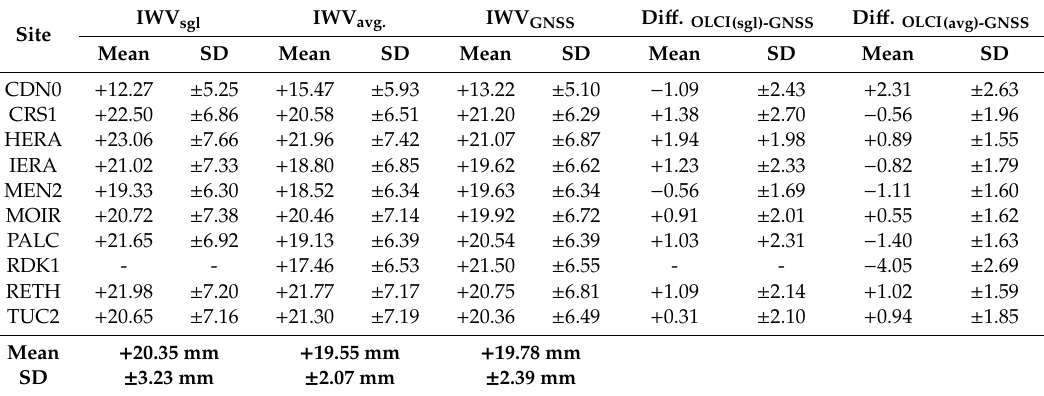
Table 3. The mean and standard deviation (SD) for the IWV values derived from Sentinel-3A OLCI using the “single point” (IWV sgl ) and the “area-of-influence” (IWV avg ) approaches, and from the GNSS, as well as for their di ff erences at each GNSS station. All values are in [mm]. The overall mean and SD per IWV determination are given in